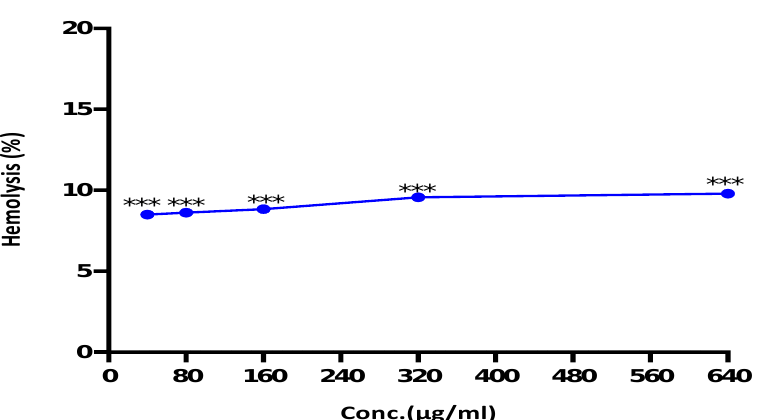
Figure 8. The hemolytic activity of R. nomadica venom against human RBC s incubated with serial concentrations of the crude venom for 1 h at room temperature. PBS and 10% triton 100 × were used as negative and positive controls, respectively. The absorbance of the supernatant was measured at 570 nm. Data are analyzed with one-way ANOVA followed by Tukey’s test. Values are represented as mean ± SEM. *** denotes significance difference ( p < 0.001) vs. control.